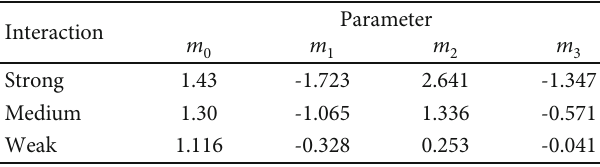
Table 2: Fluid density data for di ff erent fl uid-bearing surface interactions [24].